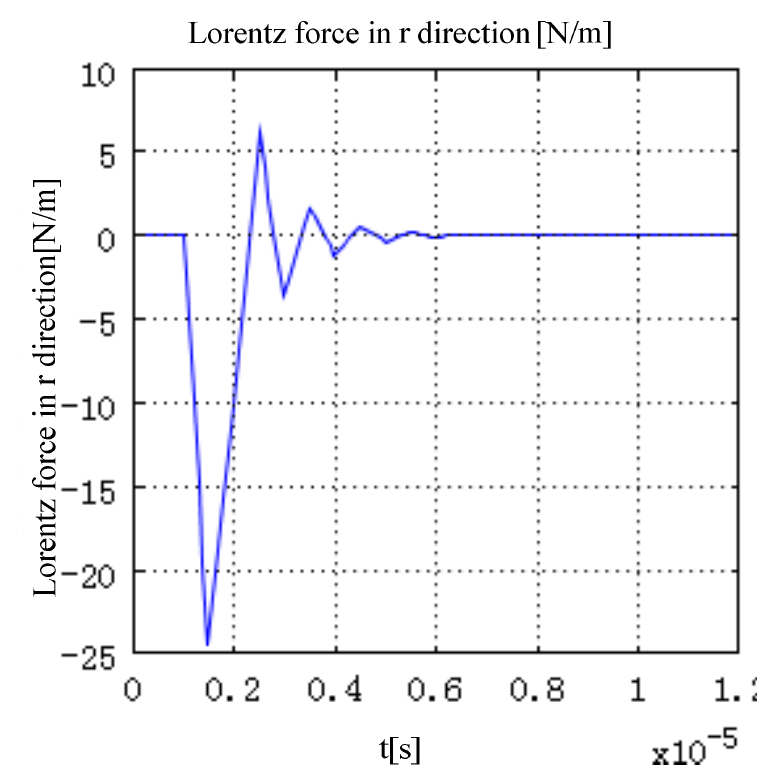
Figure 4. Lorentz force in direction .